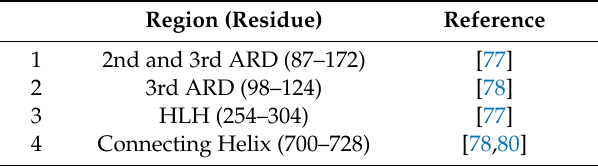
Table 2. Summary of domains responsible for homo- or hetero-tetramerization of TRPC 4 channels.